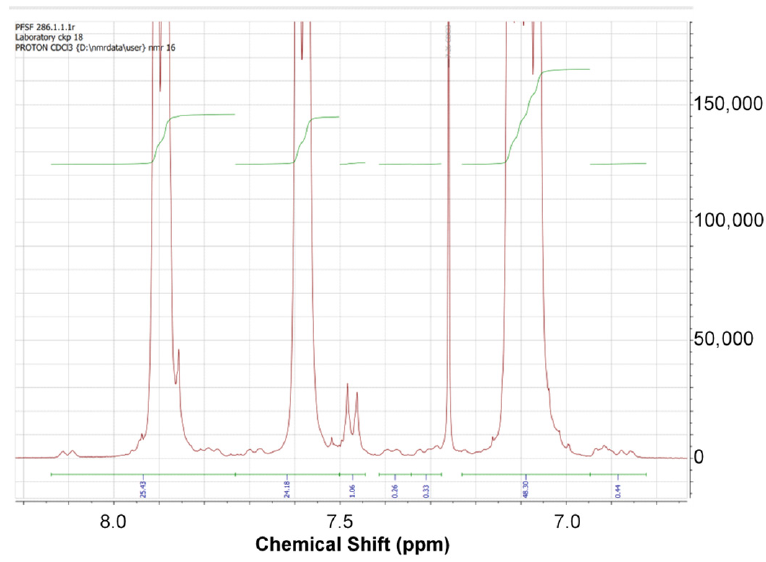
Figure 3. General view of the proton NMR spectrum. Table 3. Assignment of proton signals to the corresponding groups.